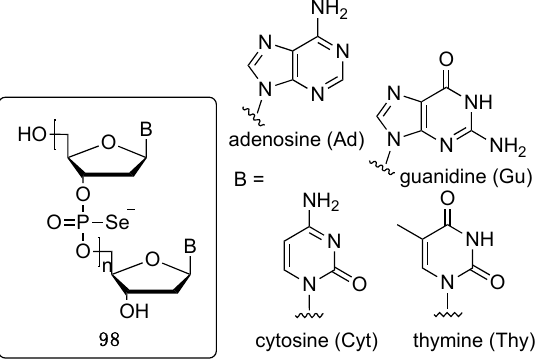
Figure 7. Structures of the phosphoroselenoates synthesized by Stec and studied by Mori.